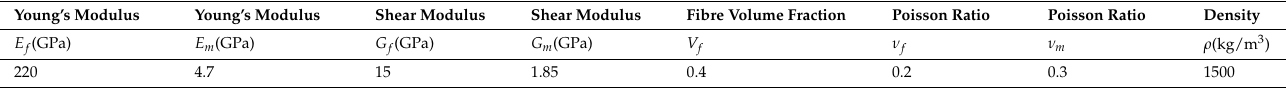
Table 2. Material properties of the homogenized CFRP layer (subscript f refers to fibre and m refers to matrix) [39]. Young’s Modulus Young’s